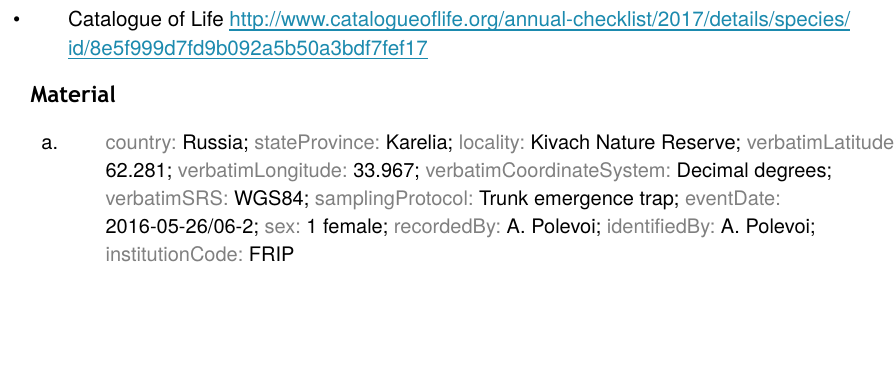
2002). First record for Europe. Ecology